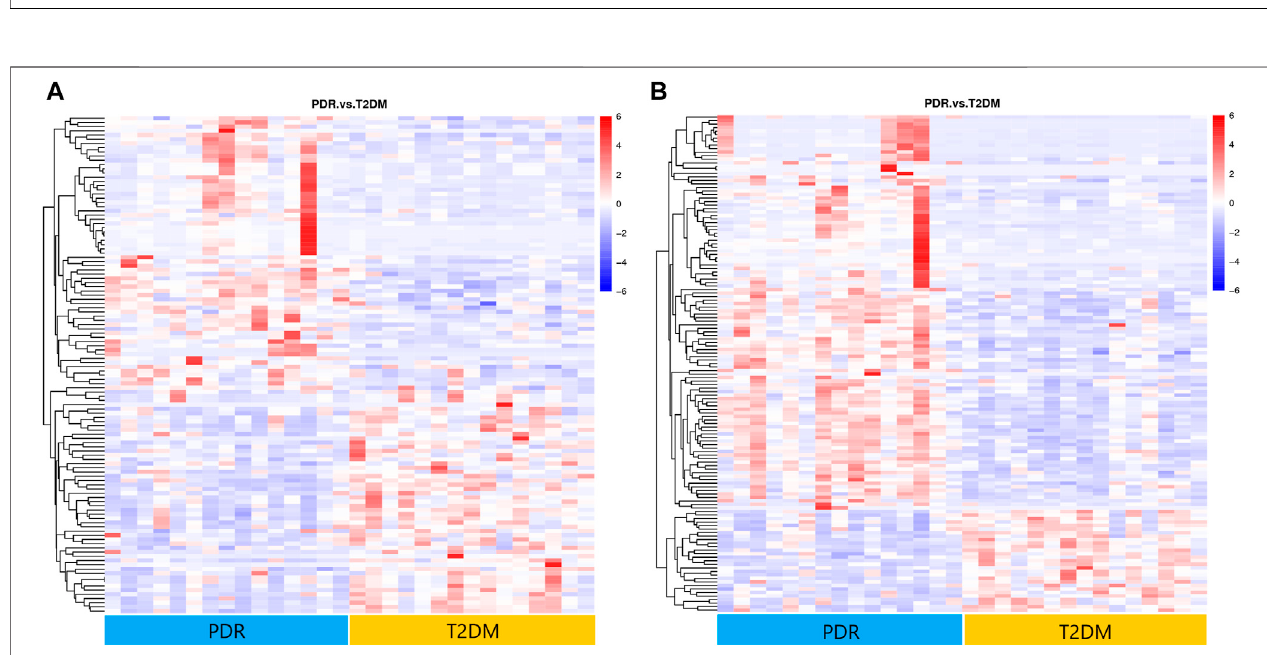
FIGURE 5 | Serum levels of (A) glutamate, (B) phosphatidylcholine, and (C) 13-hydroperoxyoctadeca-9,11-dienoic acid were elevated in NPDR patients. Metabolites enriched in the pathway analyses were further analyzed with p ≤ 0.05 and using LC-MS/MS, revealing glutamate ( p = 0.036, AUC = 0.733, VIP = 1.054), phosphatidylcholine ( p = 0.022, AUC = 0.740,VIP = 1.581), and 13-hydroperoxyoctadeca-9,11-dienoic acid ( p = 0.002, AUC = 0.835, VIP = 2.622) levels were signi fi cantly increased in NPDR patients compared with T2DM patients. AUC, area under the curve.